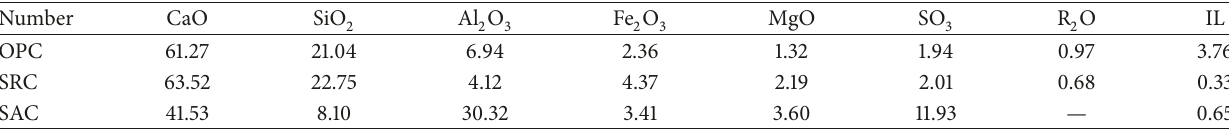
Table 1: Chemical compositions of cement (wt.%).